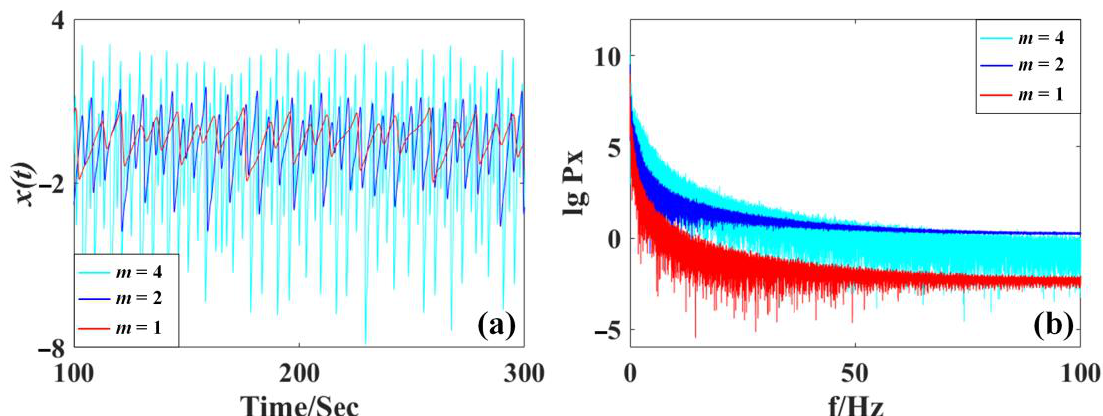
Figure 1. Waveform and frequency spectra of x from the system (5) with a = 0.5, b = 0.6, c = 1.2 and initial values of (0, 1.3, 1): ( a ) chaotic signal x ( t ), ( b ) frequency spectra of the signal x ( t ).